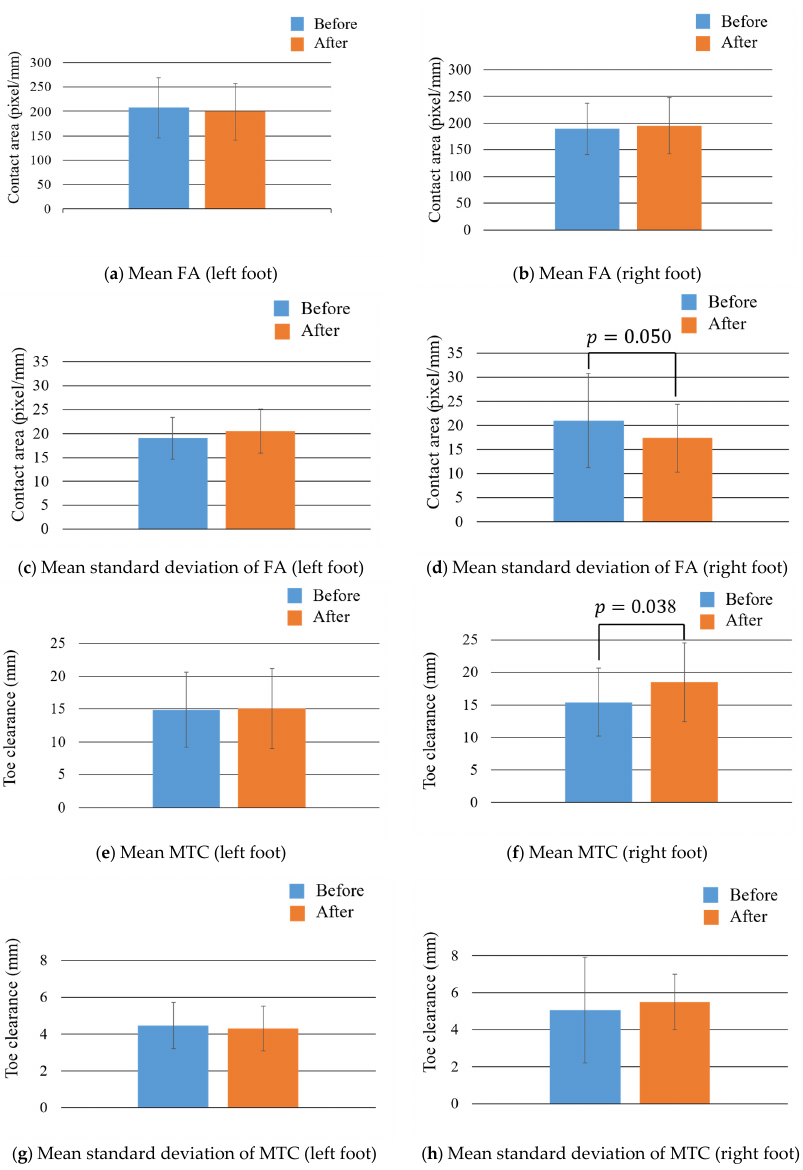
Figure 10. Mean values and mean standard deviation values of FA and MTC for all the participants. Table 1. Mean values and mean standard deviation values of FA and MTC for all the participants and changes in them owing to fatigue. Before After Rate of Change p -Value 1 Left foot FA (mean (pixel/mm) ± std.) 210 ± 62 200 ± 190 ± 49